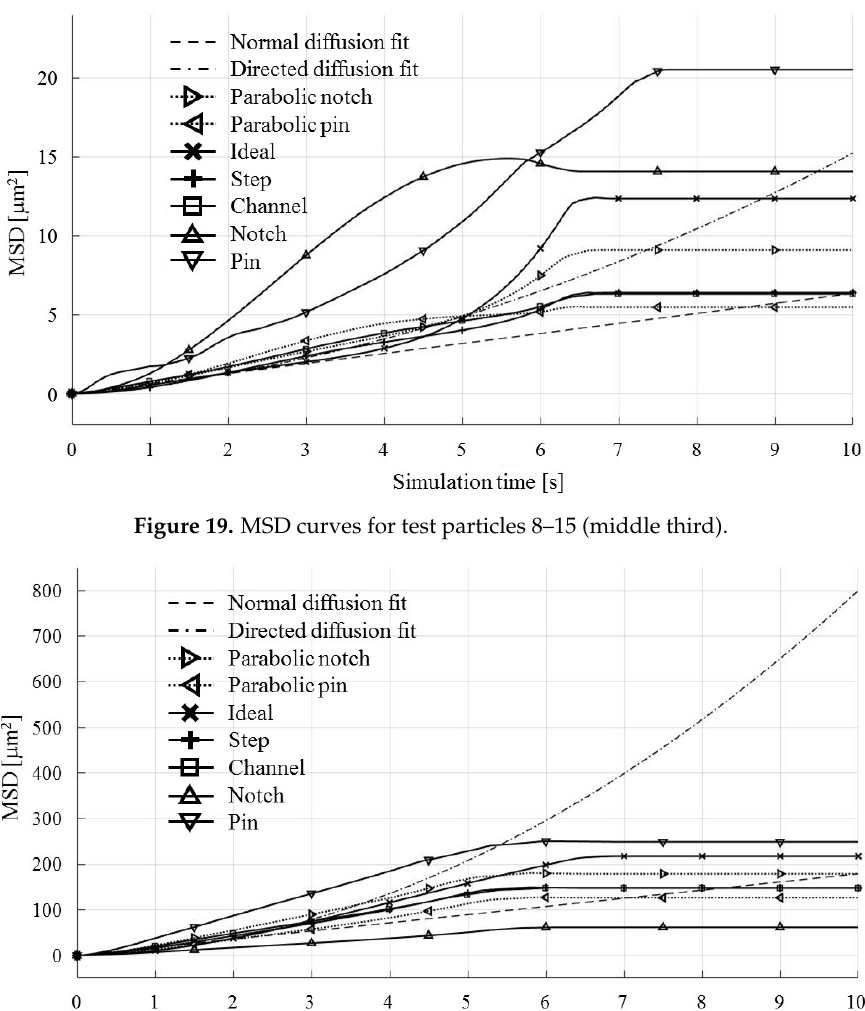
Figure 20. MSD curves for test particles 16–21 (right third).